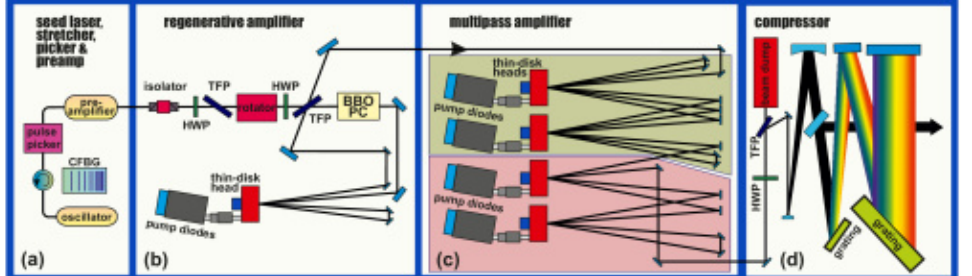
Figure 9. ( a – d ) Detailed sketch of the complete laser system. The seed pulses from the oscillator are stretched with a CFBG and first amplified by the regenerative amplifier, employing an industrial thin-disk laser head. The multipass contains 2 amplification stages, as indicated by the green (stage 1) and red (stage 2) areas. In each stage two industrial thin disk laser heads are employed. The grating compressor is set up in a folded Treacy-type near-Littrow configuration. TFP: Thin-film polarizer. HWP: Half-wave plate. BBO PC: BBO-based Pockels cell